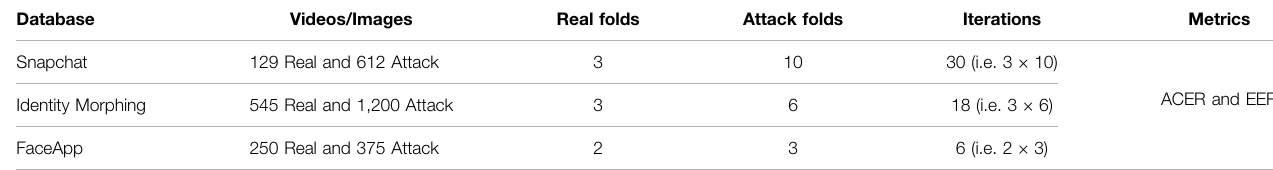
TABLE 2 | Experimental protocol of each of the proposed